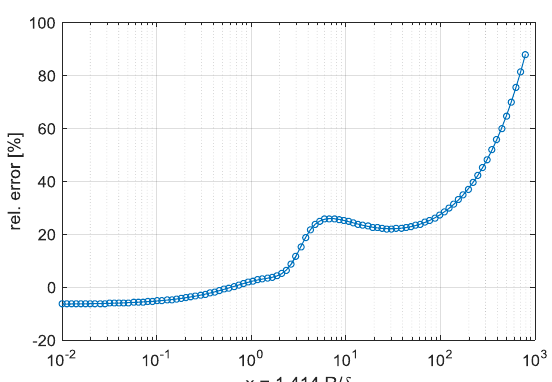
Figure 3: Semi logarithmic plot of the relative error of function (36) for the relative internal inductance in function of the dimensionless frequency 𝑥 .